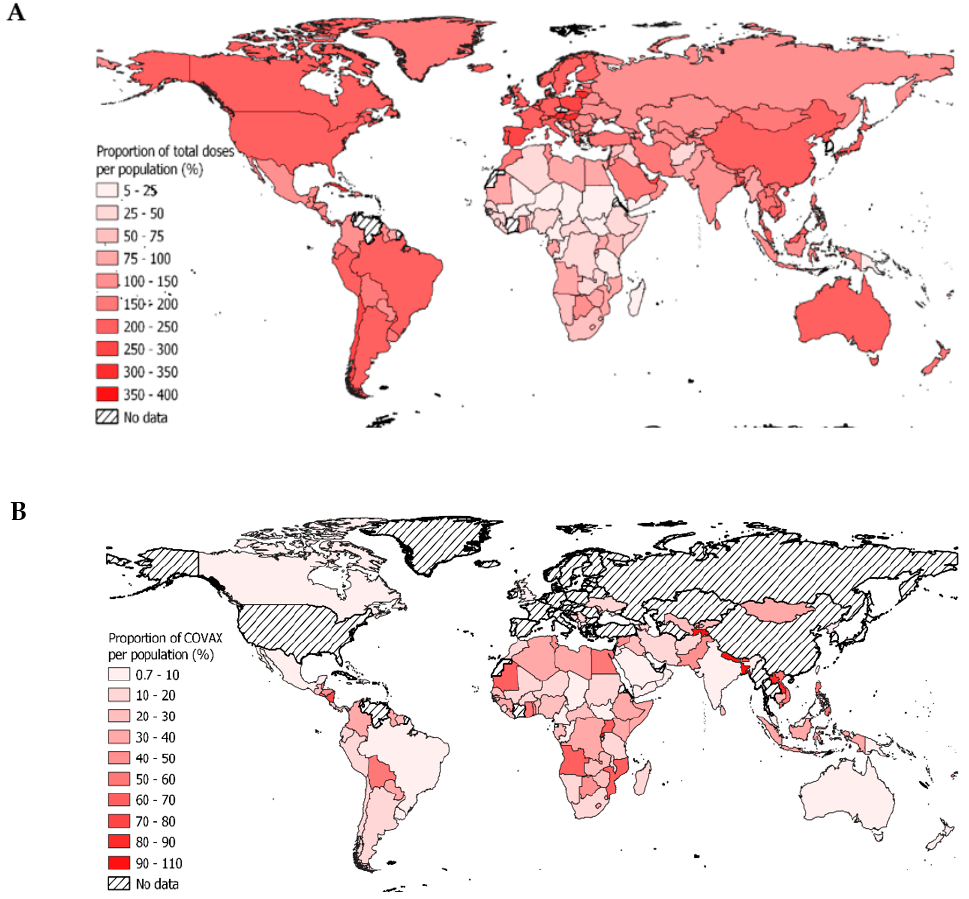
Figure 1. ( A ) Total vaccine doses delivered as a percentage of the population per country. ( B ) Vac- doses delivered by COVAX as a proportion of the country’s total cine doses delivered by COVAX as a proportion of the country’s total population.